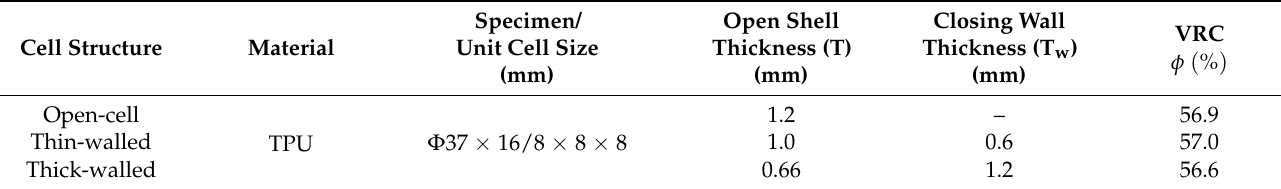
Figure 2. Designed model ( a ) open-cell lattice ( b ) thin-walled closed-cell lattice ( c ) thick-walled closed-cell lattice. Table 1. Parameters of analysed lattice